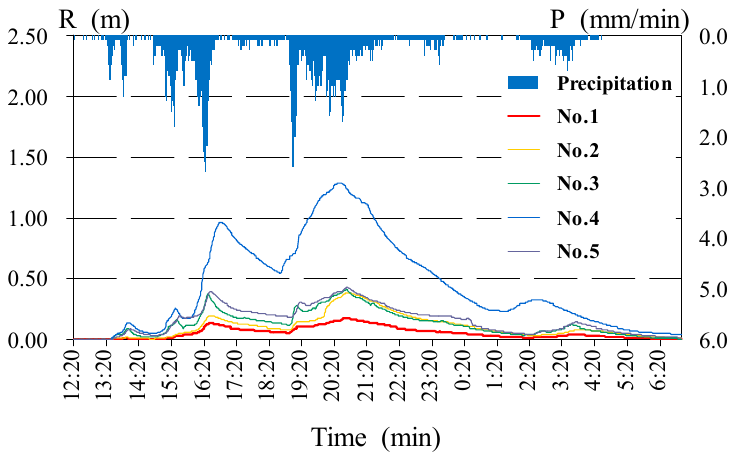
Figure 5. Simulated “7.21” runoff processes in different positions. Table 4. Calibrated results of the parameters.